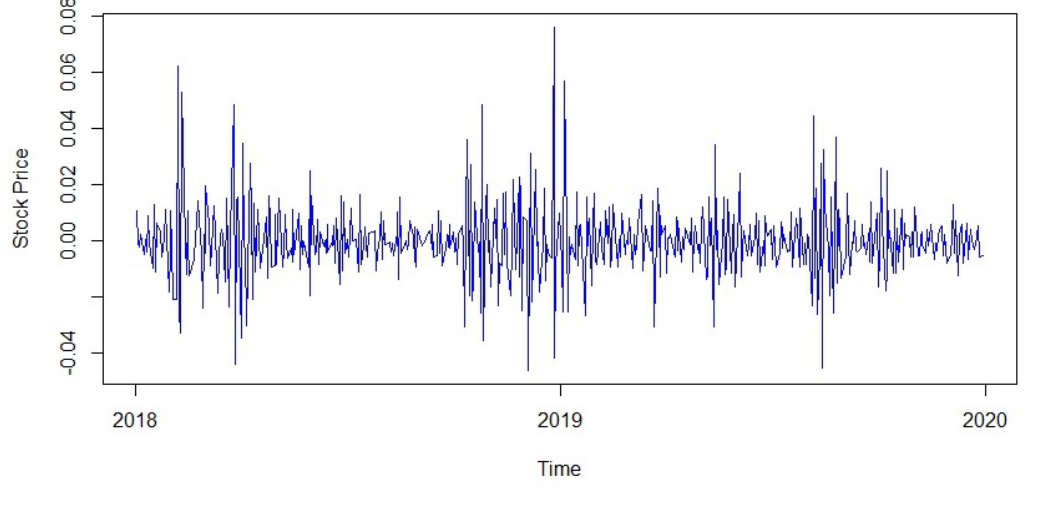
Figure 3. Window plot of the second differenced log transformed stock price.